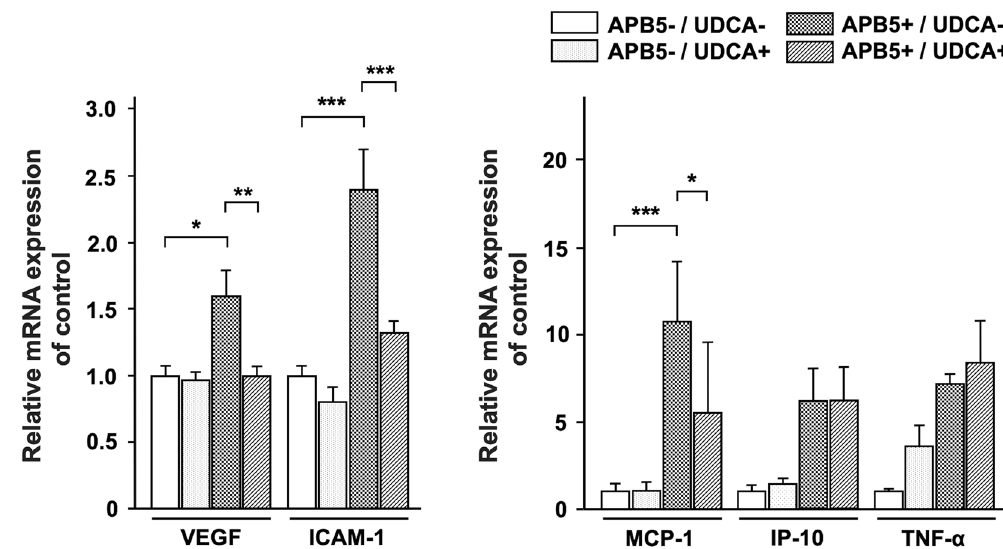
Figure 4. Retinal mRNA expression of angiogenic factors and inflammatory mediators. APB5 increased expression of VEGF, ICAM-1, and MCP-1, and these responses were attenuated by UDCA. UDCA reduced the increased expression of VEGF, ICAM-1, and MCP-1 from APB5-induced mice (P = 0.004, P < 0.001, and P = 0.007, respectively). APB5 − /UDCA − (n = 5); APB5 − /UDCA + (n = 8); APB5 + /UDCA − (n = 8); APB5 + /UDCA + (n = 9). Data were expressed as the means ± standard error of the mean (S.E.M.). * P < 0.05, ** P < 0.01, *** P < 0.001 (one-way